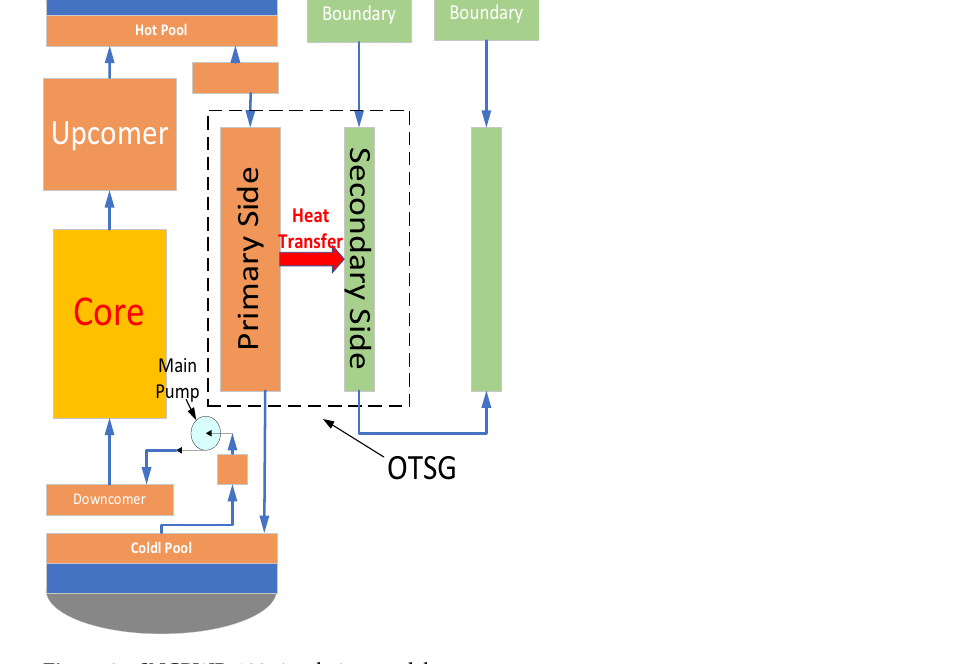
Figure 2. SNCPWR-100 simulation